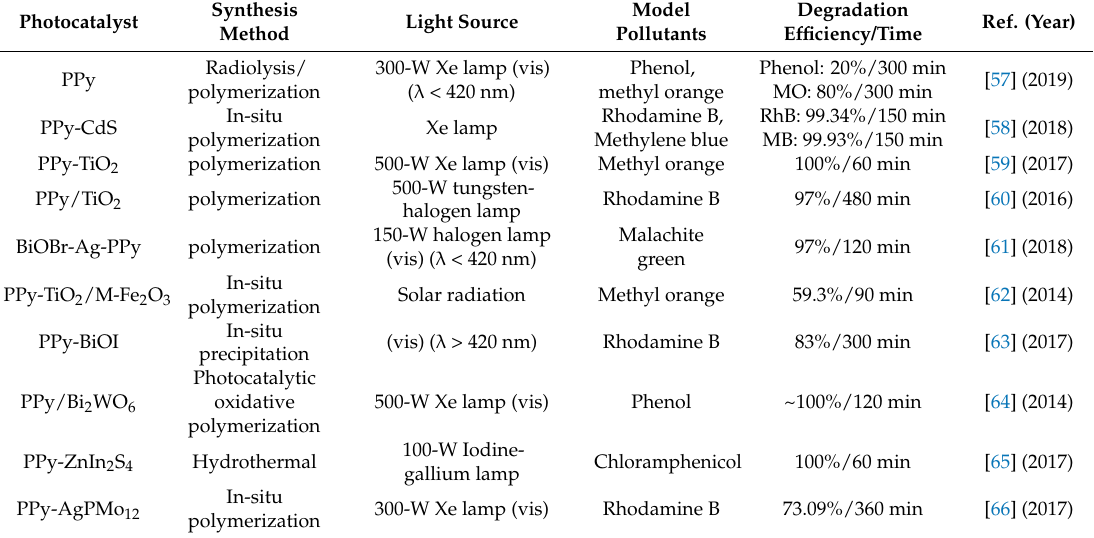
Table 5. Compositions, preparation methods, testing conditions, and photodegradation efficiency of polypyrrole based composite